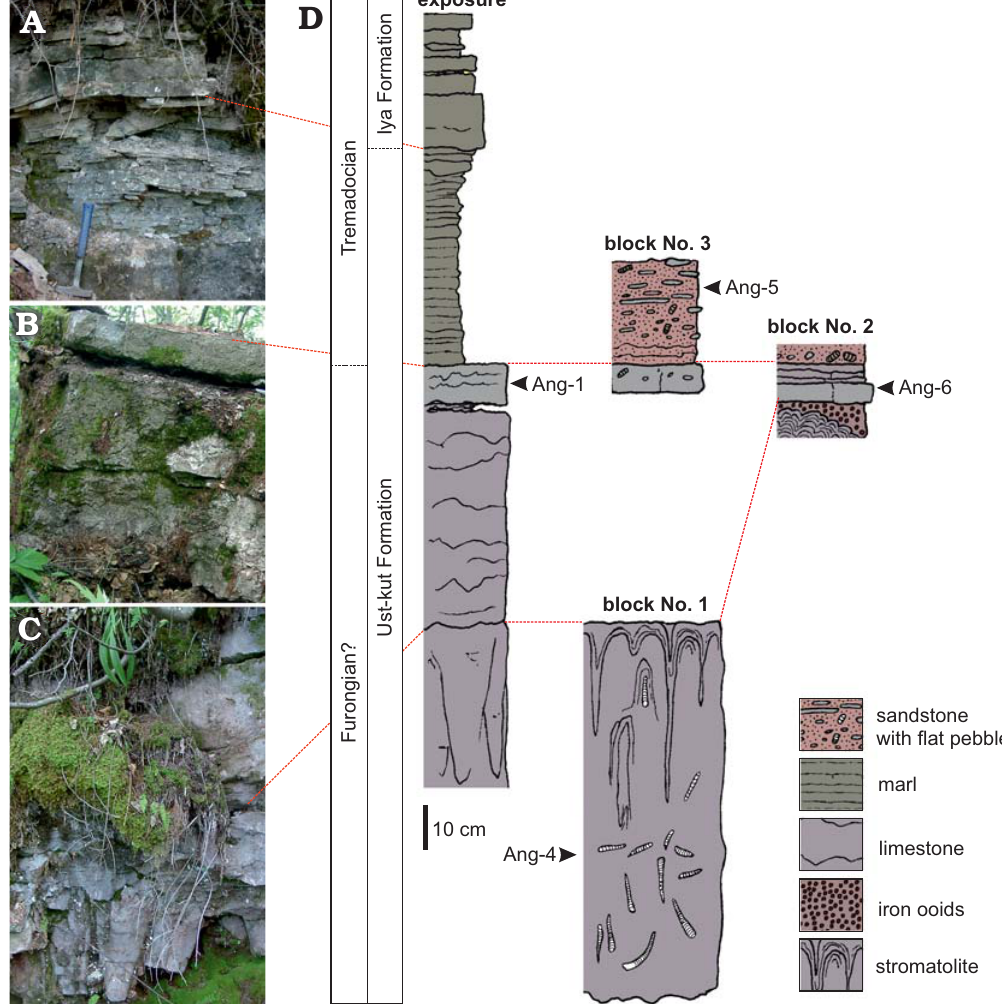
Fig. 2. Exposure of the source strata for the blocks with nautiloids found a few kilometers upstream the Angara River. A . Transition from the Ust-kut to Iya Formation. B . Top of the limestone succession of the Ust-kut Formation. C . Columnar stromatolite and limestone of the Ust-kut Formation. D . Field sketch of the section showing position of conodont samples and probable correspondence between the strata exposed and the loose